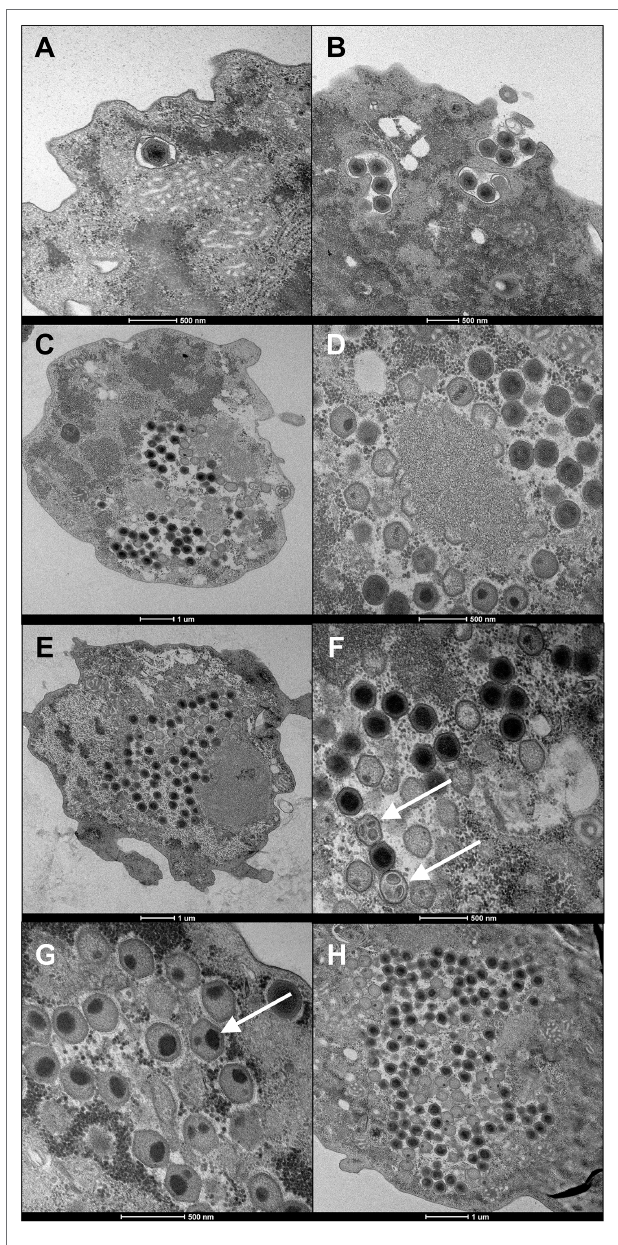
FIGURE 2 | Ultrathin section of the replication cycle of Fadolivirus IHUMI- VV54. Scale bars are indicated under each panel. (A, B) were observed during viral entry at 0 h and two hours post-infection. (C) Represents a section of Vermamoeba vermiformis 12 h post-infection. (D) High magnification of a viral factory 16 h post-infection. (E) New virus produced 20 h post-infection. (F, G) White arrows indicate icosahedral capsid with ovoid points intra-capsidic localization. (H) Intra-cytoplasmic viruses observed 24 h